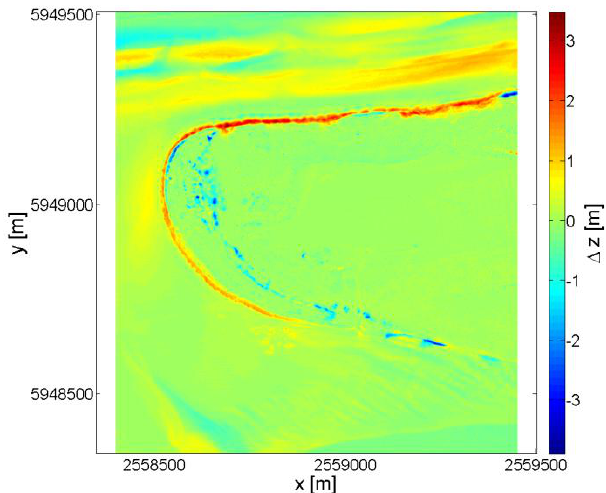
Figure 6. Differences between DTM 2010 and 2004 at the western border of